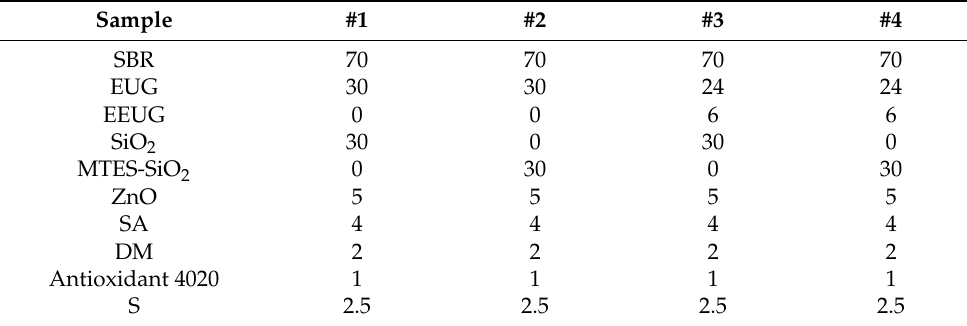
Table 1. Rubber composite formula